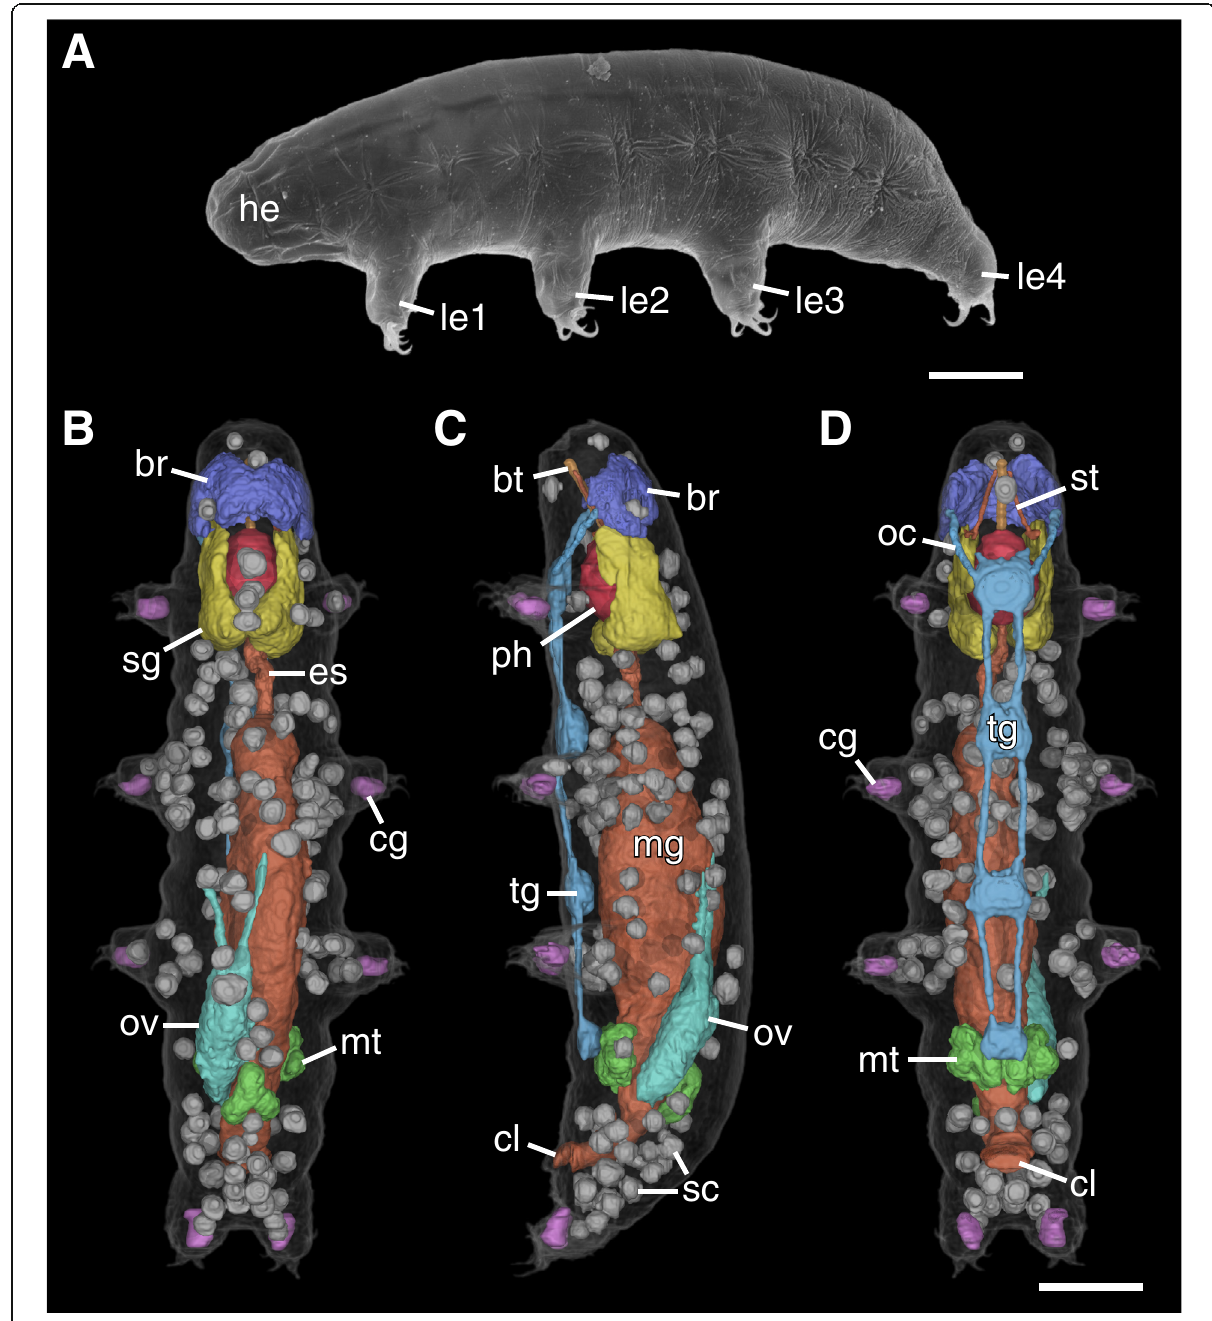
Fig. 1 The tardigrade Hypsibius exemplaris . a Scanning electron micrograph of an adult specimen. Lateral view; anterior is left, dorsal is up. b - d 3D renderings of X-ray nanoCT data showing the entire body and all segmented organs in dorsal ( b ), lateral ( c ), and ventral ( d ) views. Anterior is up. Note the large salivary glands (yellow), the ovary and its two anterior ligaments (teal), and the distribution of storage cells (gray) throughout the body. Abbreviations: br, brain; bt, buccal tube; cg, claw glands; cl, cloaca; es, esophagus; he, head; le1 – le4, legs one to four; mg, midgut; mt, Malpighian tubules; oc, outer connectives; ov, ovary; ph, pharynx; sg, salivary glands; sc, storage cells; tg, trunk ganglion. Scale bars: 20 μ m (scale bar in d for b - d